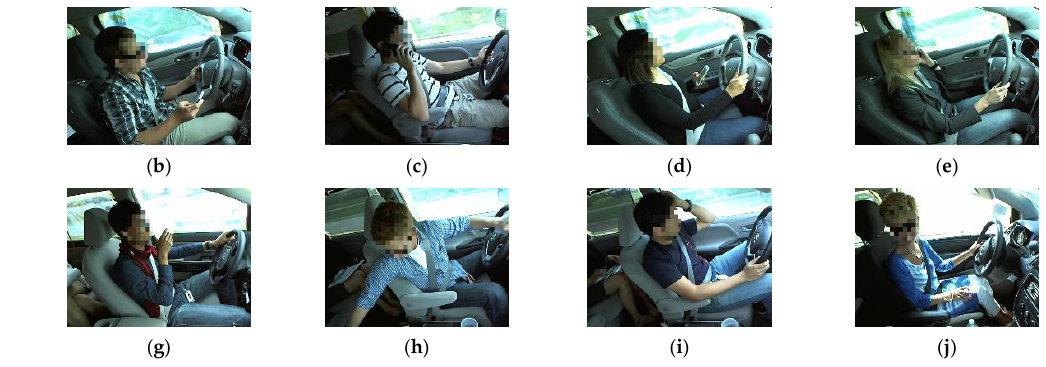
Figure 5. Some sample pictures from the SF3D dataset. ( a ) Safe driving ( b ), texting-right ( c ), talking on the phone-right ( d ), texting-left ( e ), talking on the phone-left ( f ), operating the radio ( g ), drinking ( h ), reaching behind ( i ), hair and makeup ( j ), talking to passenger.